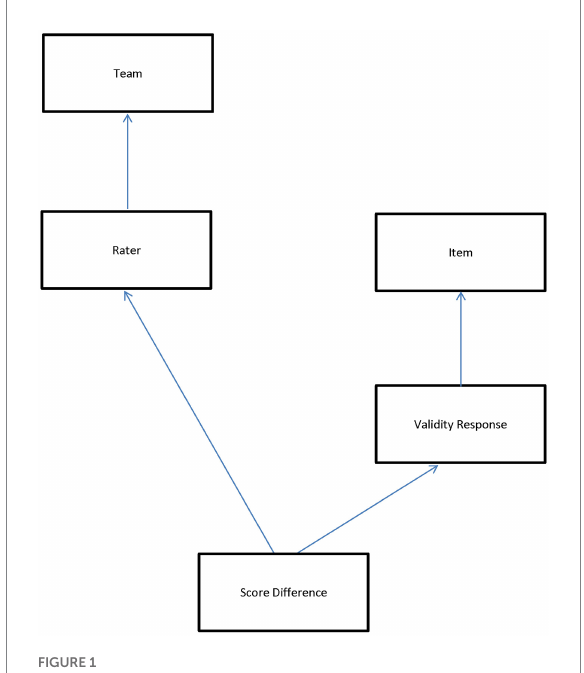
FIGURE 1 Cross-classification data